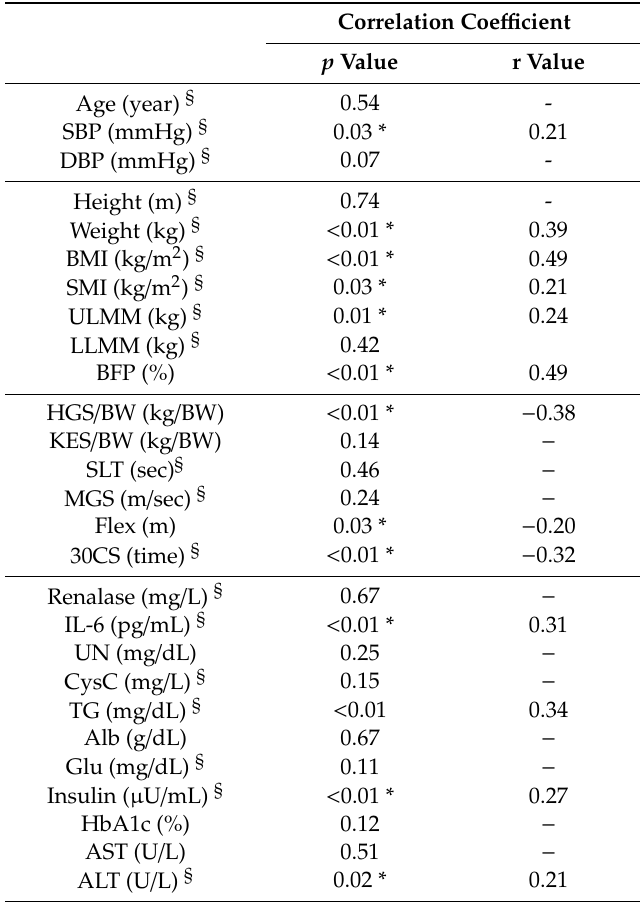
Table 2. Correlation of sarcopenia-related parameters based on estimated salt